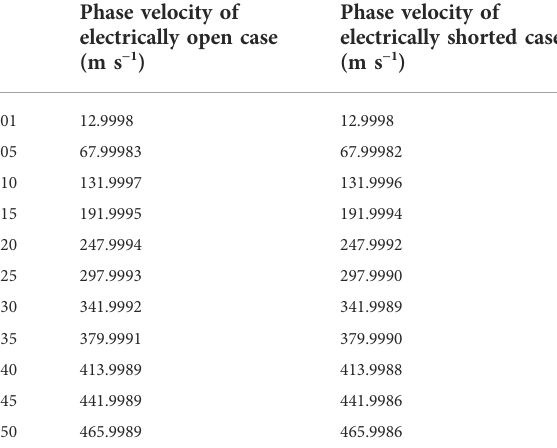
TABLE 2 Phase velocity of different electrical conditions at the free edge calculated by